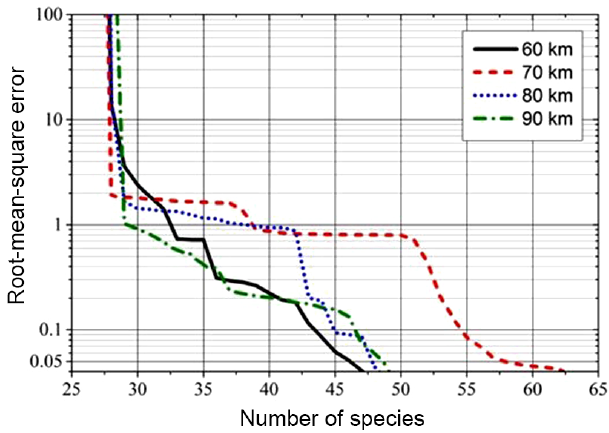
Figure 1. Root-mean-square (rms) error of all species as a function of number of species in the reduced mechanism for the four selected altitudes (60, 70, 80 and